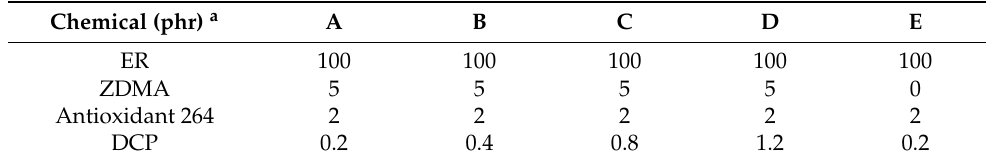
Table 1. Formulation of the ER